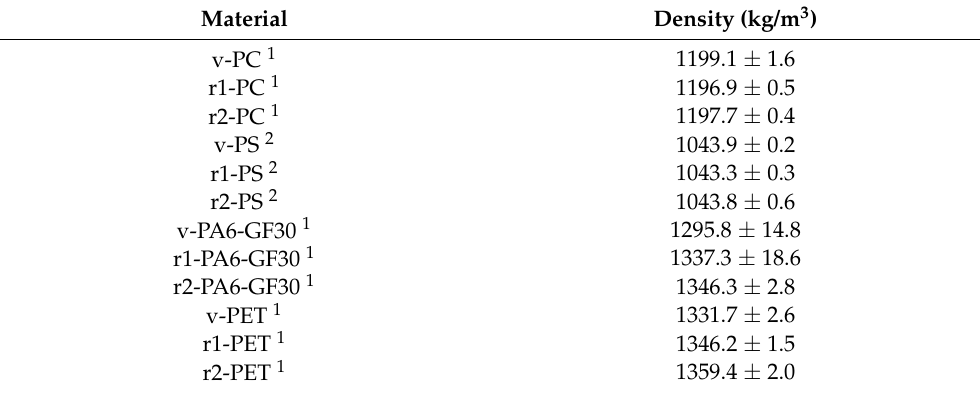
Table 1. Density of the studied materials was tested according to the guidelines in ISO 1183-1:2019 [19].